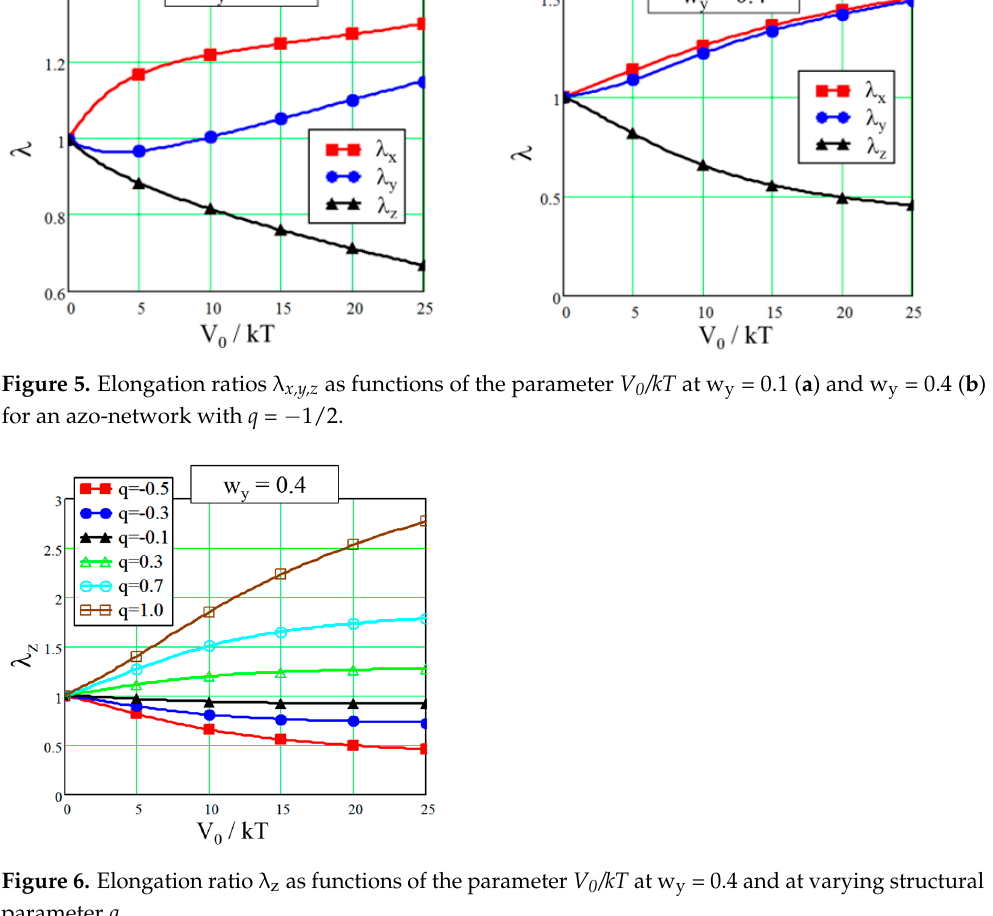
as functions of the parameter V z